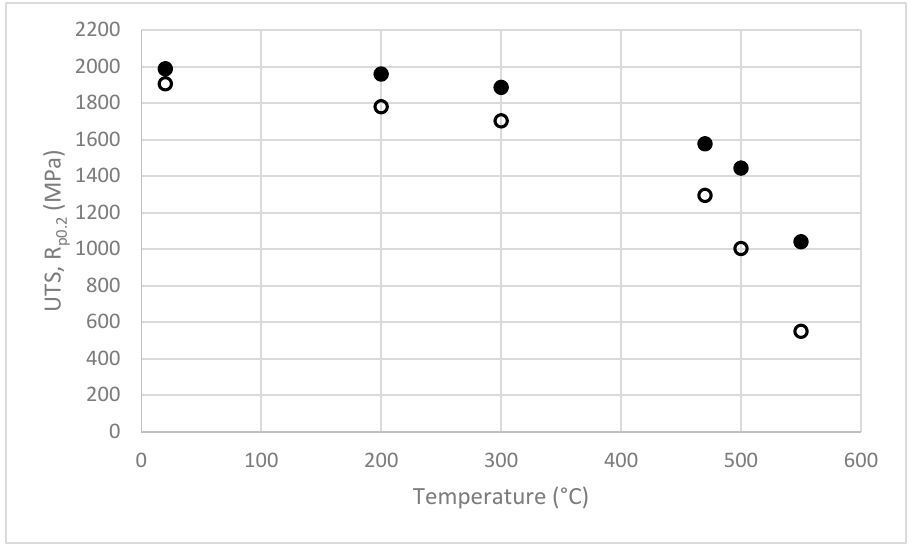
Figure 4. The relationship of UTS (full circles) and R p0.2 (empty circles) of tested steel within the temperature range of 20° to 550 °C.